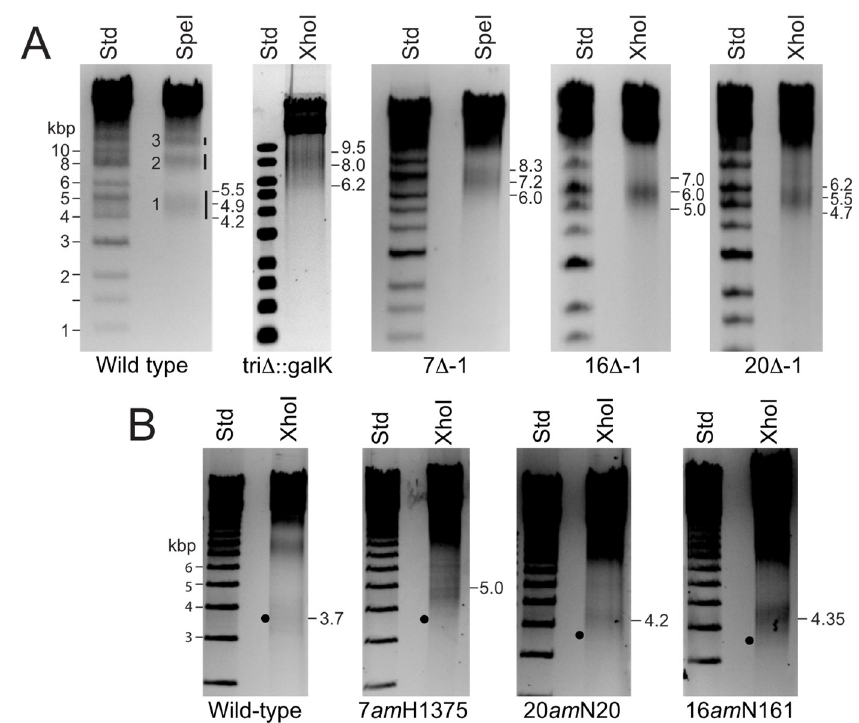
Figure 2. P22 virions without E-proteins contain longer DNA molecules. (Panel A ) Virion DNA from “wild-type” P22 strain UC-0937 and its derivatives P22 7 − ∆-1, P22 16 − ∆-1, P22 20 − ∆-1 and P22 tri∆:: galK particles were cleaved with restriction enzyme XhoI or SpeI as indicated and the products displayed in a 0.6% agarose electrophoresis gel; restriction enzymes were chosen that best position the right-end fragment for measurements in the gel. A lane with molecular weight standard DNA fragments (Std) is shown on the left in each gel. To the right of the wild type phage DNA lane, black vertical bars mark the “fuzzy” right end fragments, and their packaging series headful numbers are indicated on the left. The sizes in kbp of the approximate upper and lower boundaries and average size of the first headful right-end bands are indicated at the right of each gel. Note that the genome sequence lengths of the different deletion phages are not the same, so their right end fragment lengths per se do not accurately reflect the amount of DNA packaged (see text). (Panel B ) DNAs from the amber mutant particles indicated below the lanes (see text) were cleaved and the fragments separated as in panel A. Black dots indicate the expected position of the center of first headful right-end band if the packaged DNA were wild- type length.